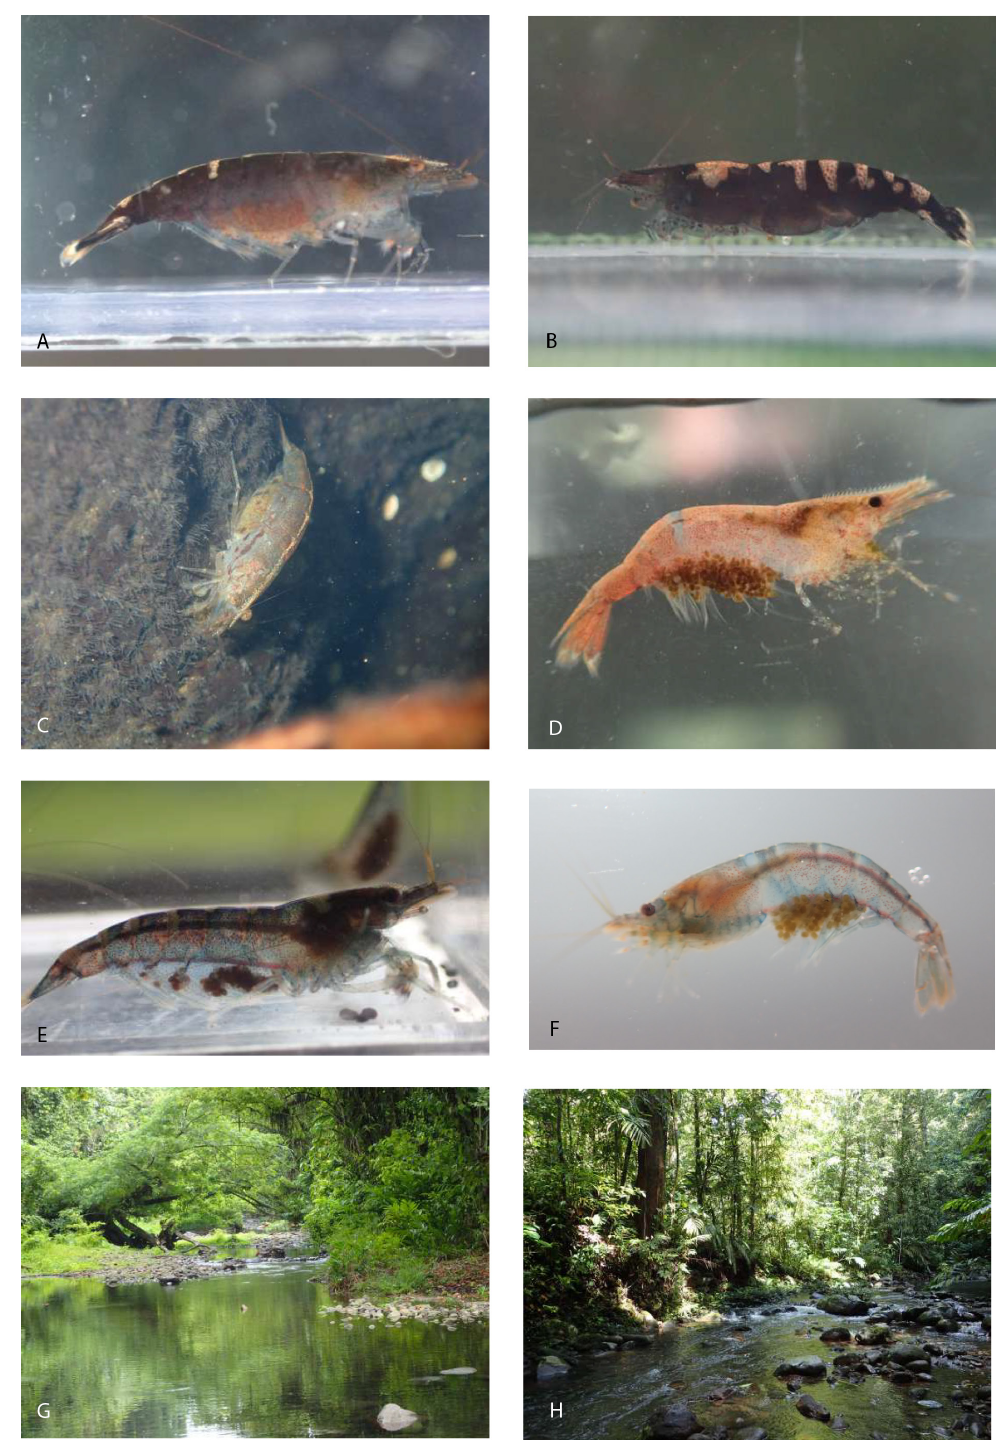
Fig. 26. Live colourations. A . Caridina buehleri Roux, 1934 (MNHN-IU-2015-20). B . Caridina gueryi Marquet, Keith & Kalfatak, 2009 (MNHN-IU-2015-19). C . Caridina weberi De Man, 1892 (Kolombangara Island). D . Caridina serratirostris De Man, 1892 (MNHN-IU-2018-2931). E . Caridina papuana Nobili, 1905 (Choiseul Island). Habitats in the Solomon Islands. F . Caridina maeana sp. nov. (Choiseul Island). G . Lentic mode, Lodumoe river, Kolombangara Island. H . Lotic mode, Sulumuni river, Kolombangara Island. Photopgraphs by P. Keith (A, D–F, H) and C. Lord (B–C,